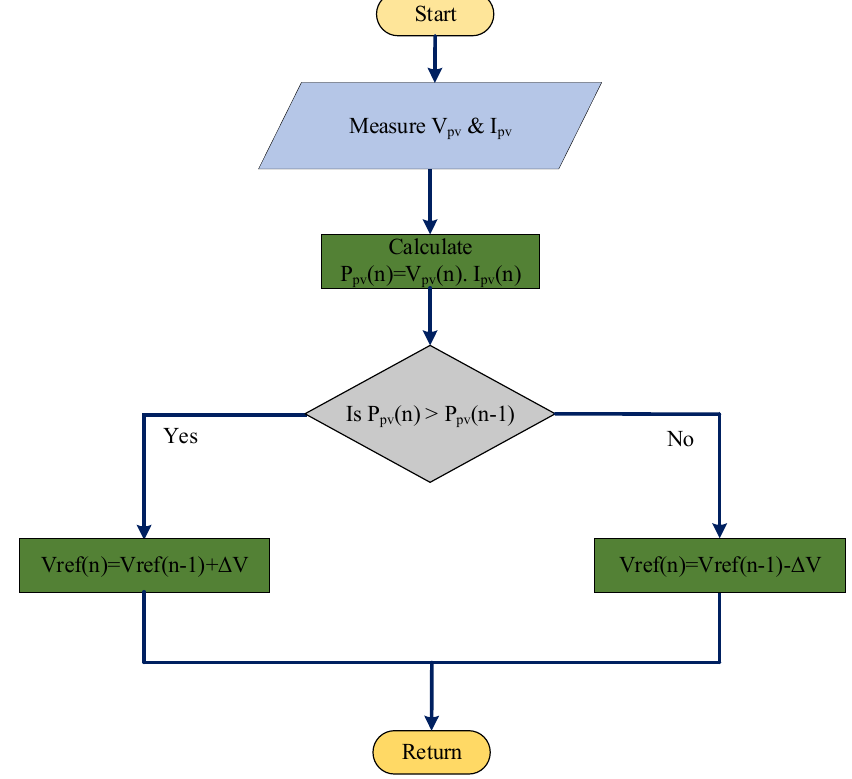
Figure 3. Flow chart of the MPPT algorithm based on the HC algorithm.